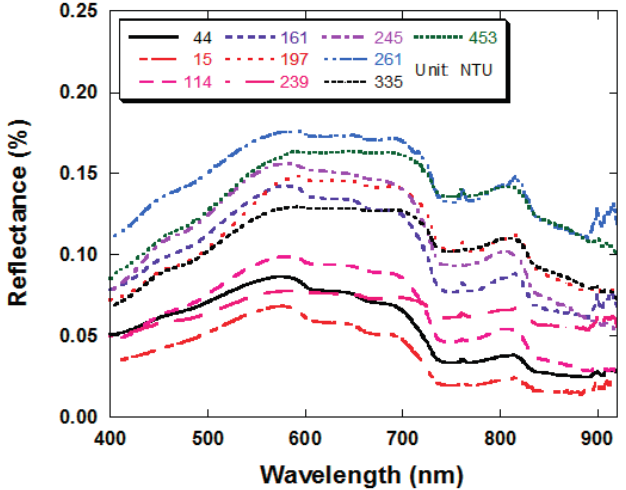
Figure 3. Representative reflectance spectra of surface water with varying concentration of turbidity in the Wu River basin,